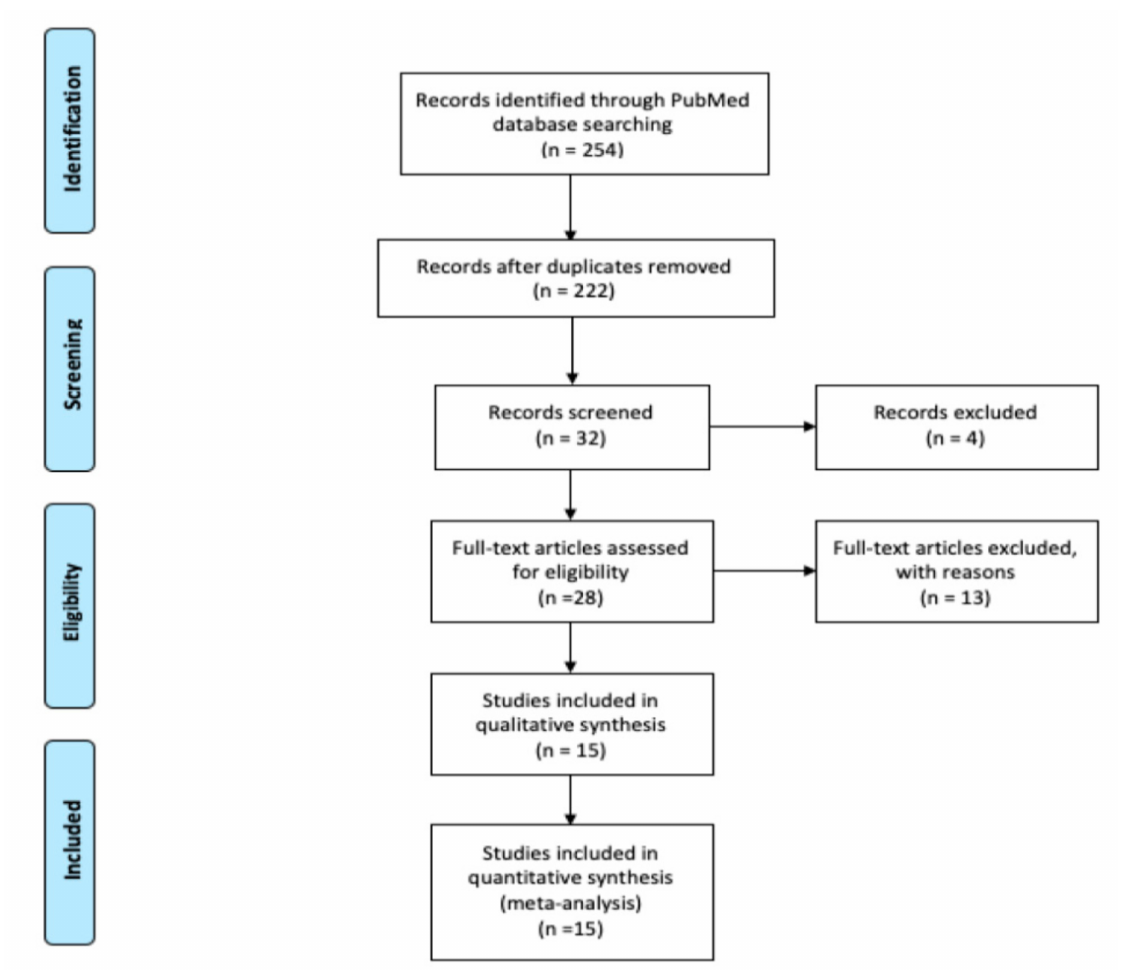
Figure 1. Flow diagram of literature search and study selection